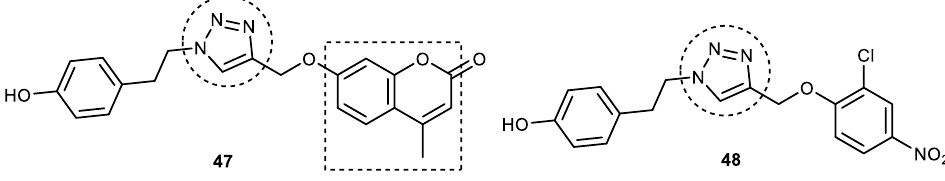
Figure 16. Chemical structure of coumarin – 1,2,3-triazole – tyrosol trihybrids.